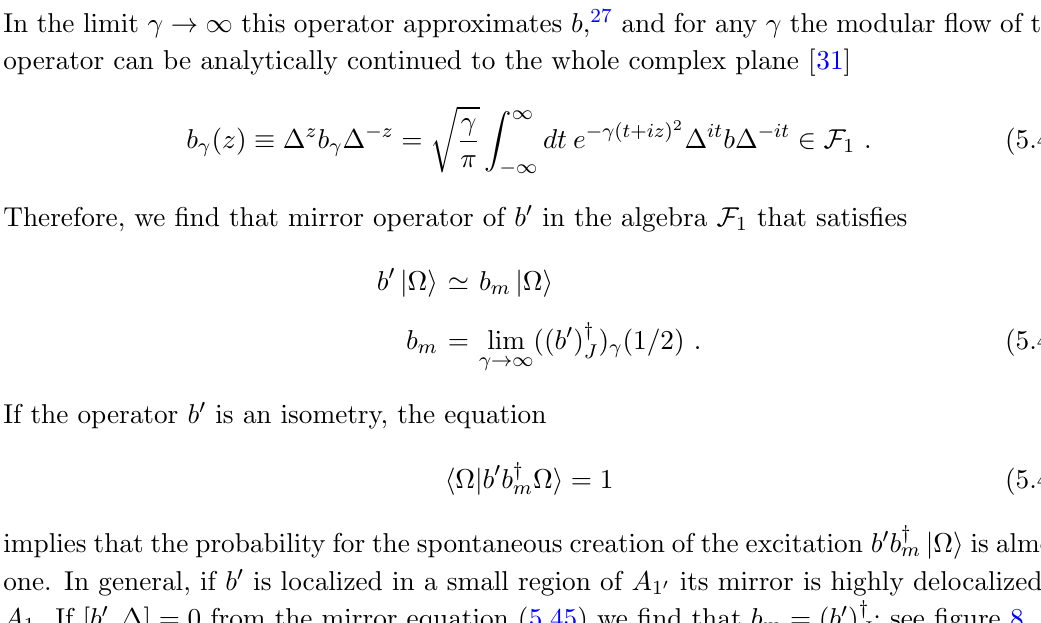
Figure 8. Consider the case where region A is the Rindler wedge and we have the vacuum of QFT (a) If b 0 is localized in the small red circle inside A 0 the operator ( b 0 circle in A , however the mirror operator in (5.44) requires boosting that spreads its support in the blue region (b) The operators in A 0 that are approximately-invariant under modular (cid:13)ow (boost) are localized in a small proper distance from the entangling surface. Their mirror operators are also localized near the entangling surface in A